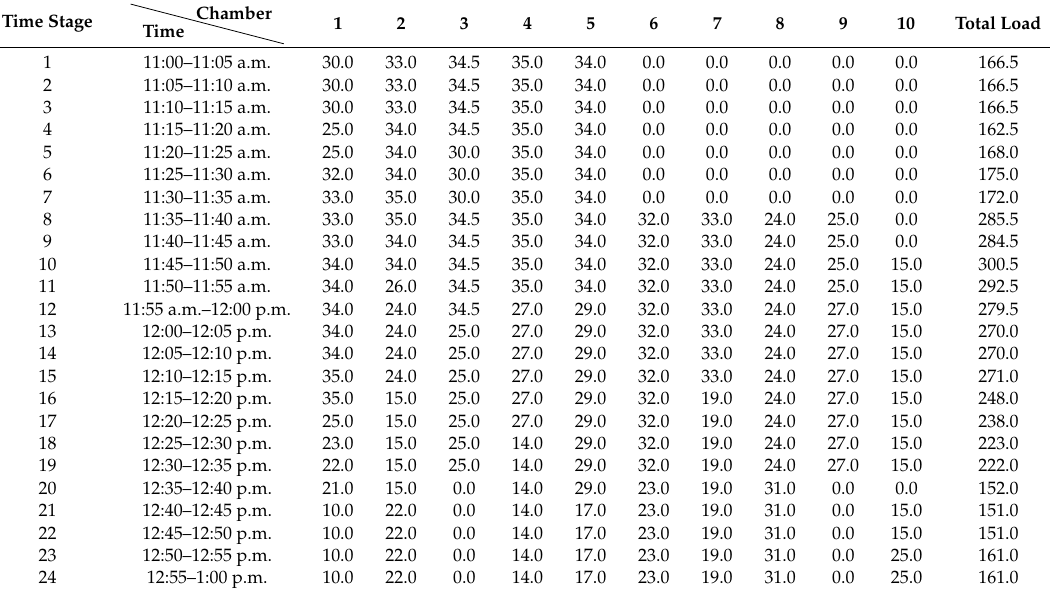
Table 4. The load changes of refrigerating chamber after the energy control